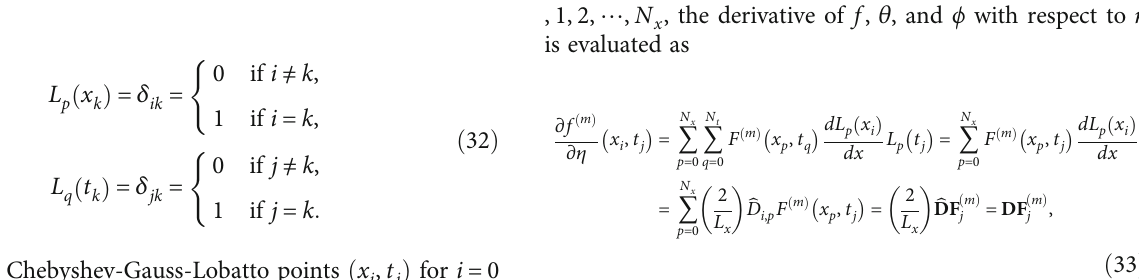
: 8, ξ = 1, N N Df = Bi = Sr = 0 : 5, He = δ b = t = w = 0